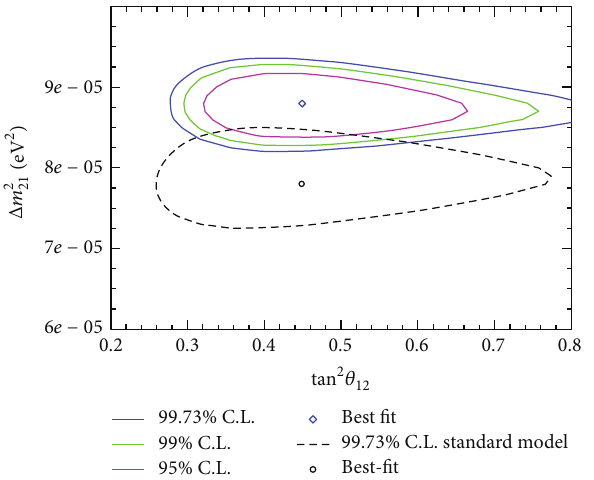
Figure 4: Result of the test for MaVaN model (color curves) compared with simulation data for the standard model (dotted line).